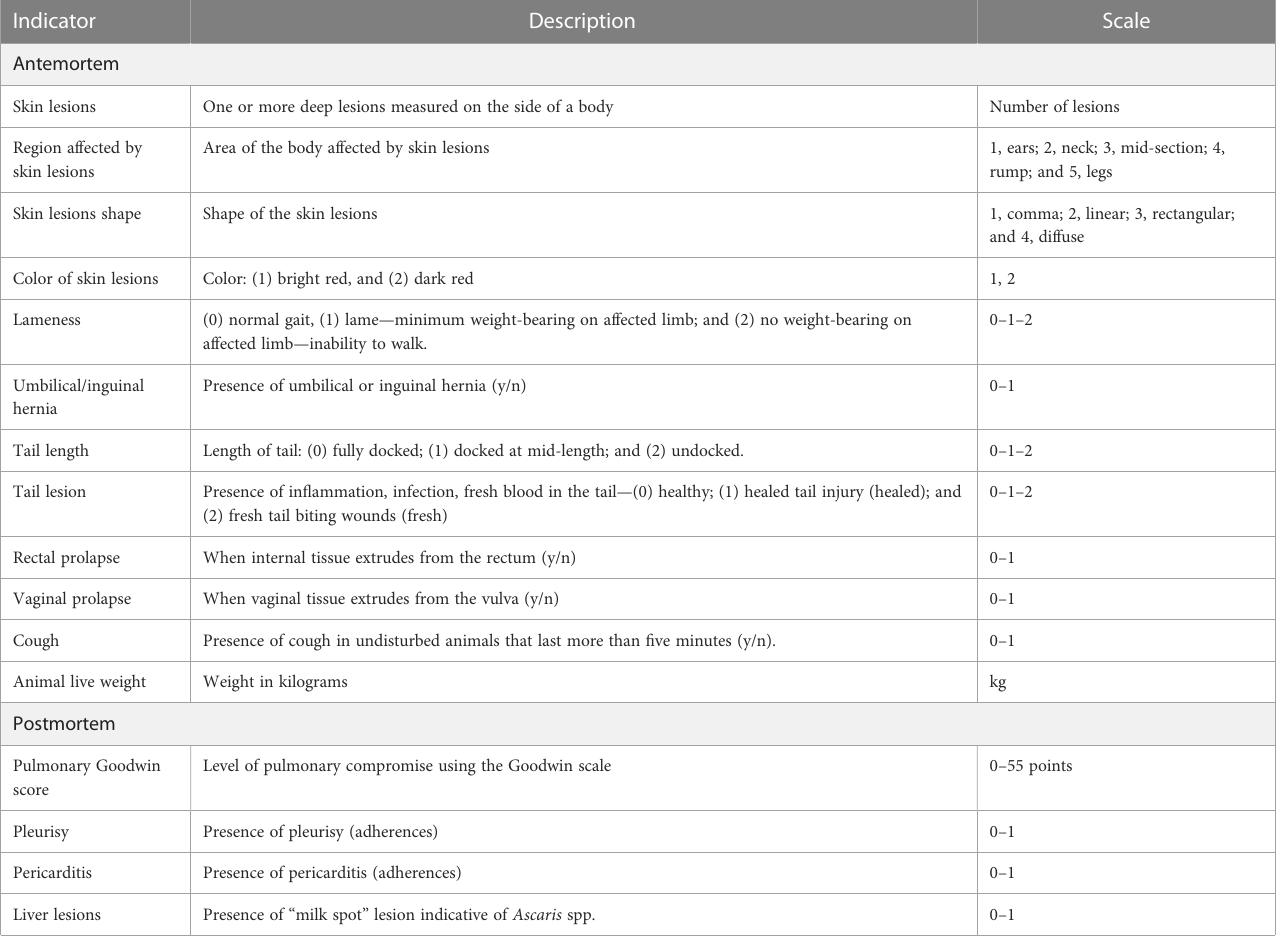
TABLE 1 Description of antemortem and postmortem indicators evaluated in the present